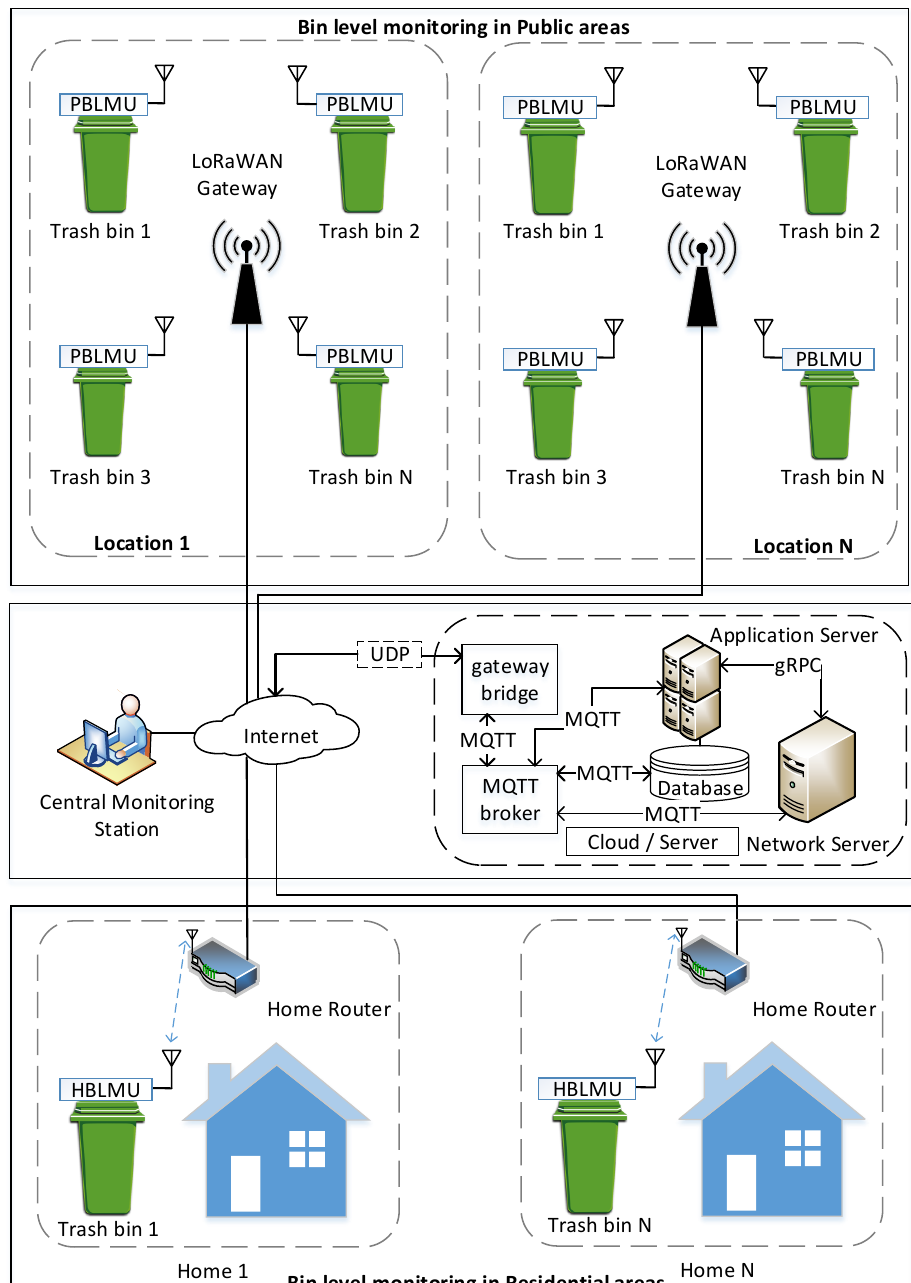
Figure 1. The network architecture of the developed